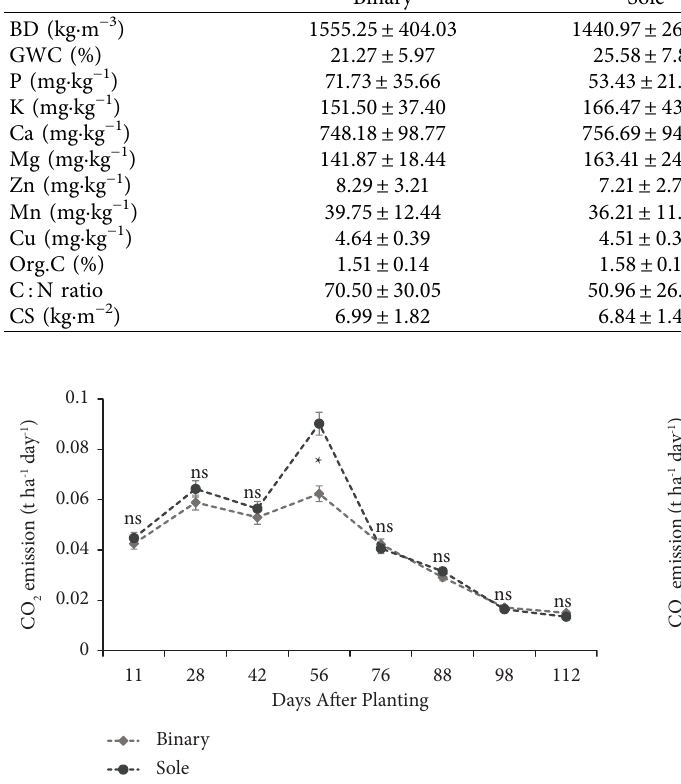
Table 2: Soil chemical properties from Ofcolaco collected at the end of 2018/19 and 2020/21 cropping seasons. Chemical properties